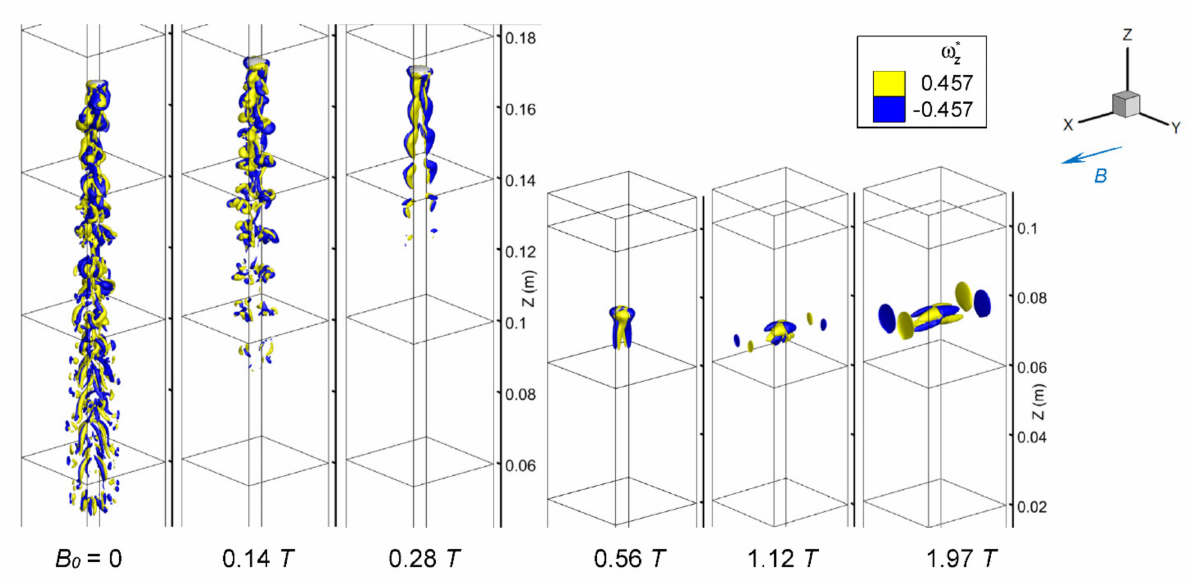
Figure 18. Iso-surfaces of non-dimensionalized vorticity ω ∗ z = 0.457 (yellow) and ω ∗ z = − 0.457 (blue). The vortices, which are shed from the bubble, persist a long distance for the case of B 0 = 0, but they diffuse away with increases in the magnetic field (see Video